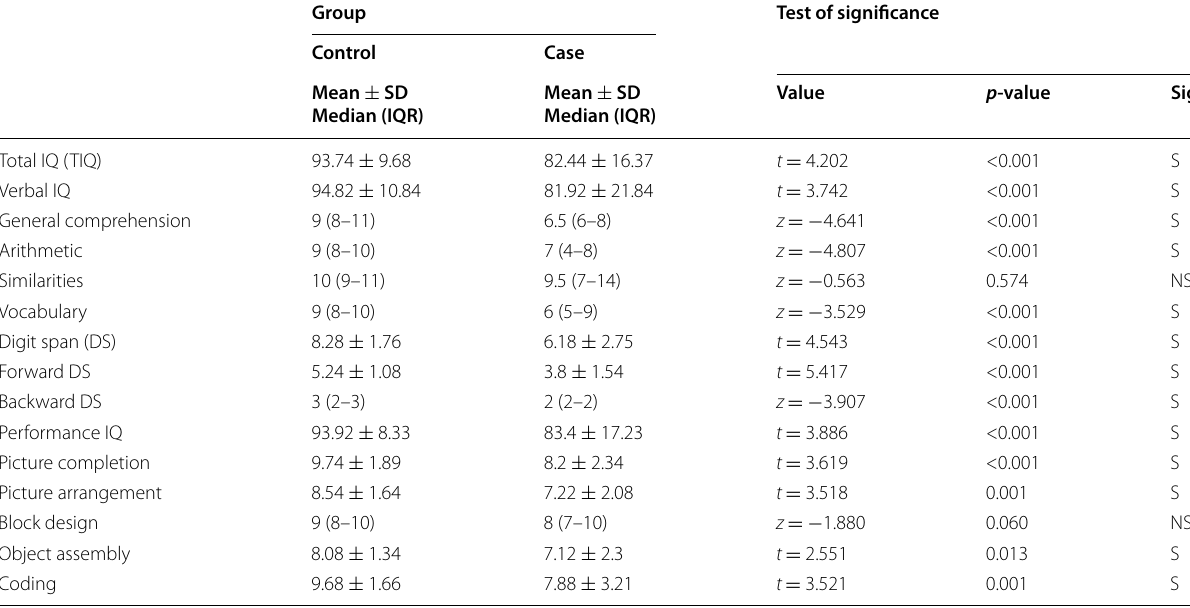
Student t test of significance ( t ). Mann-Whitney test of significance ( z